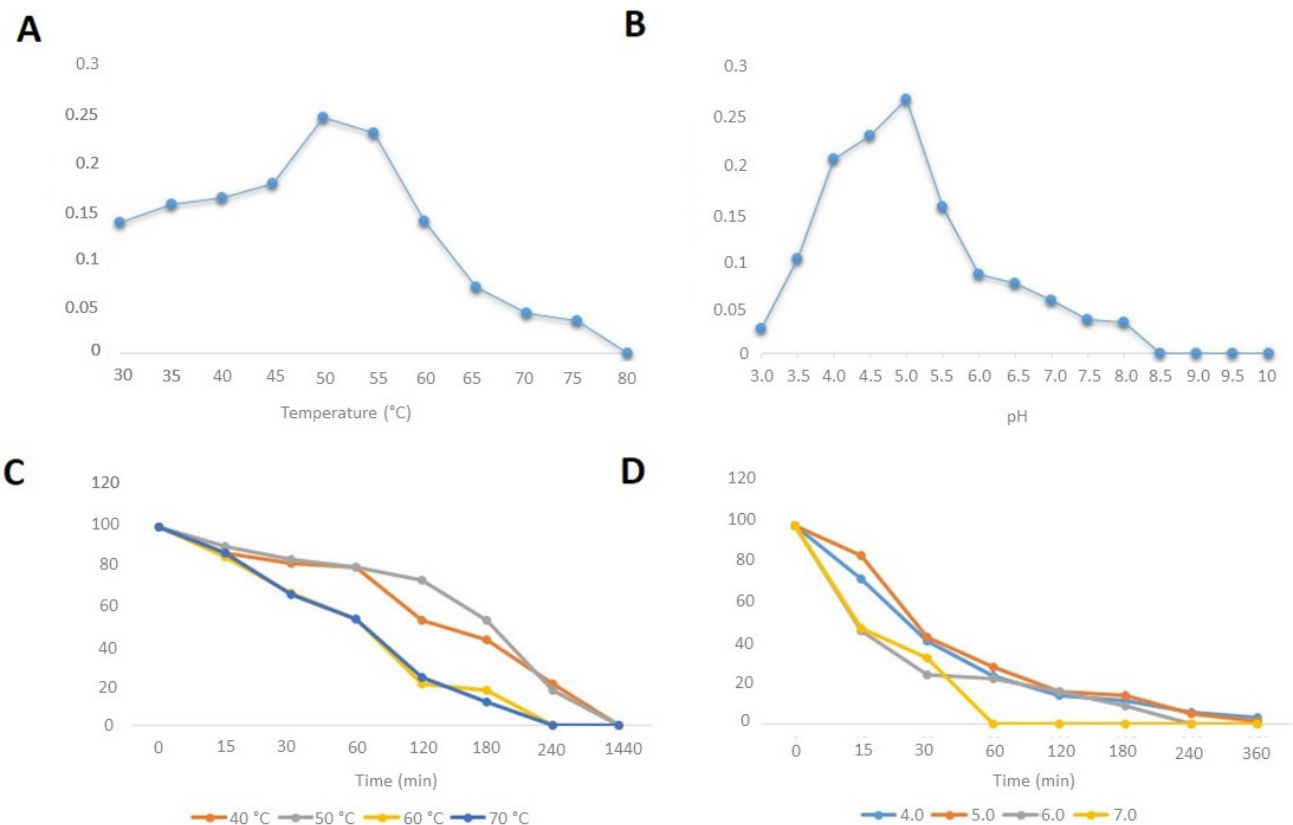
Figure 3. Biochemical characterization of T. longibrachiatum xyloglucanase. ( A )—optimal temperature; ( B )—optimal pH; ( C )—thermostability; ( D )—pH stability.